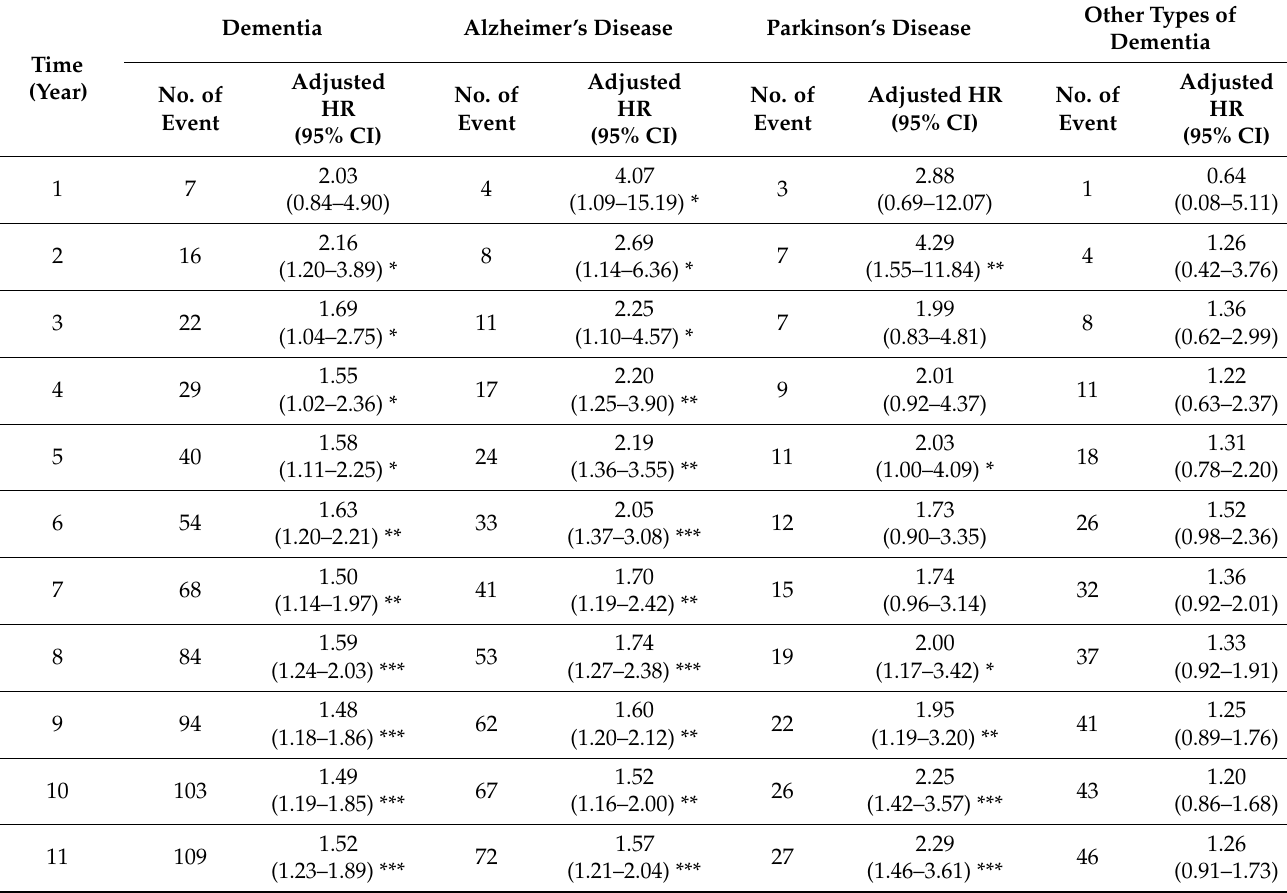
Table 4. Risk of dementia subtype in primary open-angle glaucoma (POAG) patients by time.